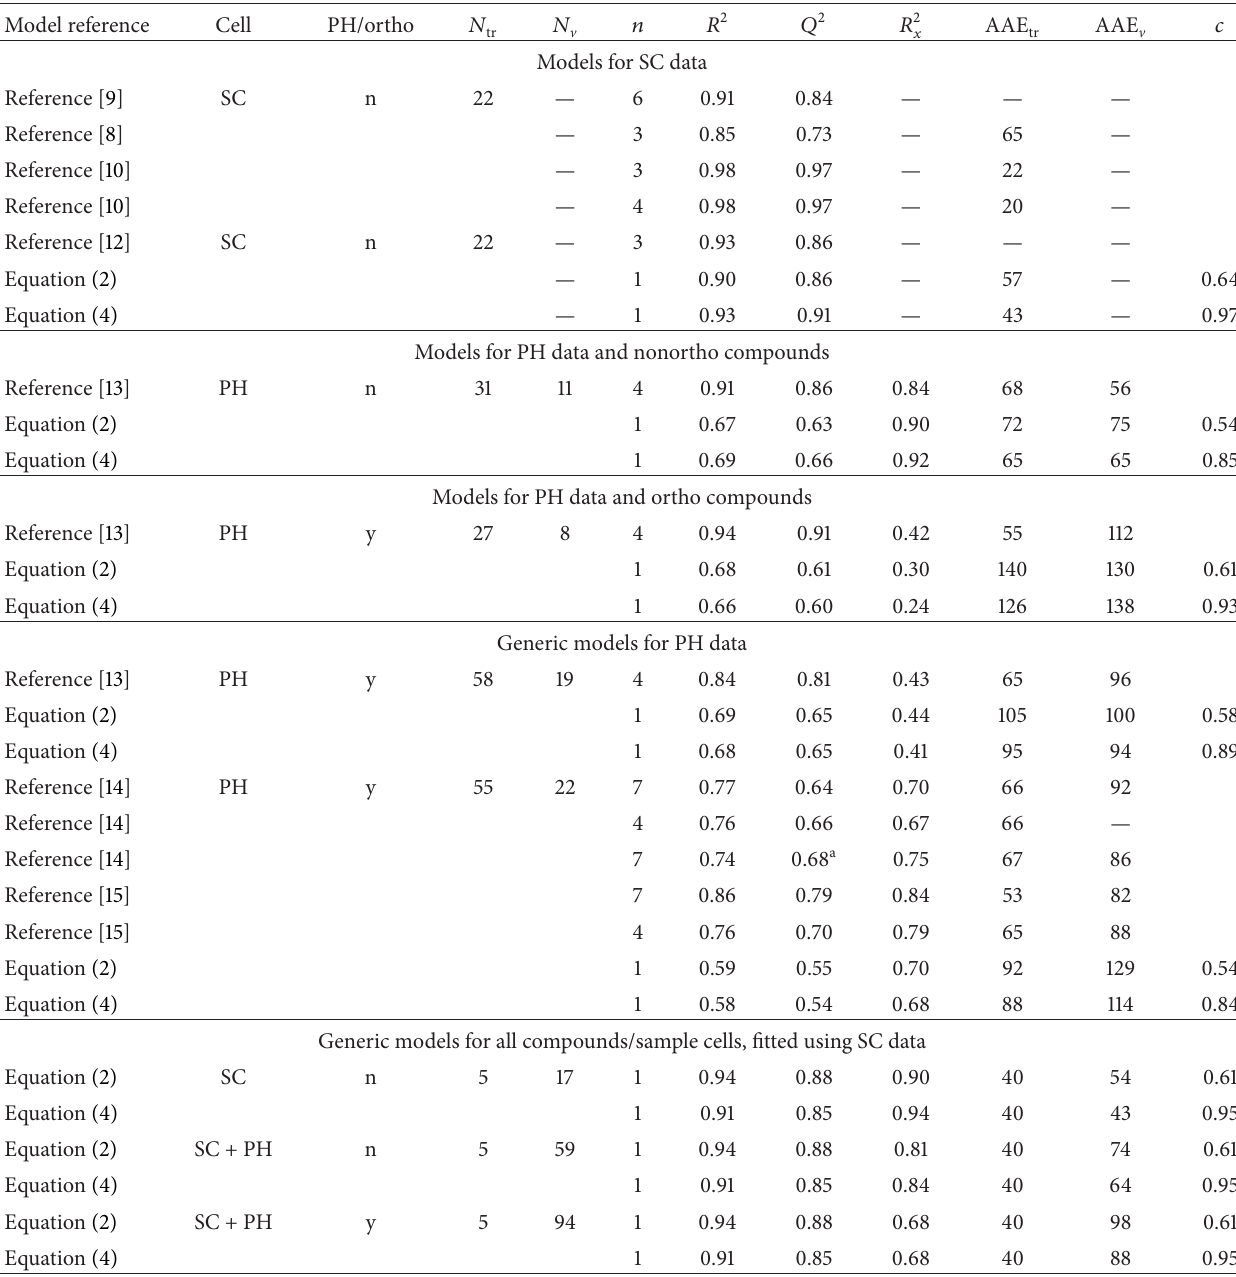
Table 1: Comparison of presently available predictive methods. The second column indicates which kind of measurements (SC and/or PH) are used to assess the predictive value of the method. In the third column, y/n indicates whether (y) or not (n) PH data for ortho compounds are included in the test set. In the last column, 𝑐 stands for the empirical parameter of present models; that is, it is equal to either 𝑓 when (2) is used or 𝑎(𝜒/𝜂) when using (4). AAE tr and AAE V values are in